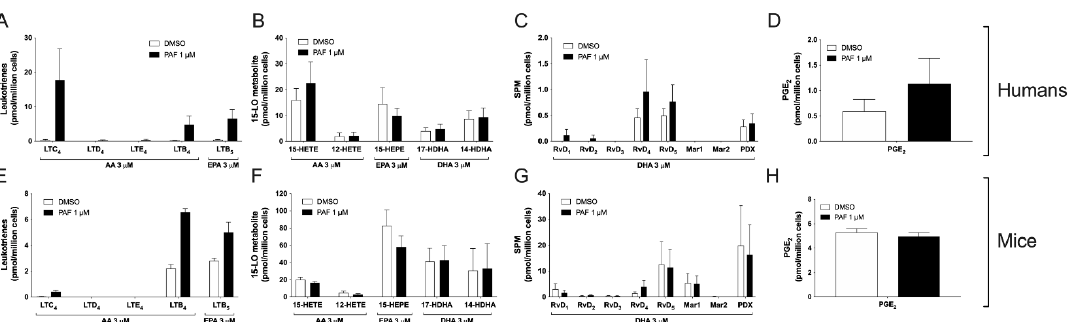
Figure 5. Impact of PAF on eicosanoid and docosanoid biosynthesis by human and mouse eosinophils. EOS suspensions (5 × 10 6 cells/mL, 37 ◦ C) were stimulated 15 min with 1 µ M PAF and 3 µ M of AA, EPA or DHA. Incubations were stopped by adding 1 volume of cold ( − 20 ◦ C) of MeOH containing the internal standards. Lipids were extracted and quantified by LC-MS/MS as described in Materials and Methods. ( A – D ) Results are the mean ( ± SEM) of 5 independent experiments using human eosinophils from asthmatic donors. ( E – H ) Results are the mean ( ± SEM) of 7 independent experiments using bone marrow-derived mouse eosinophils.